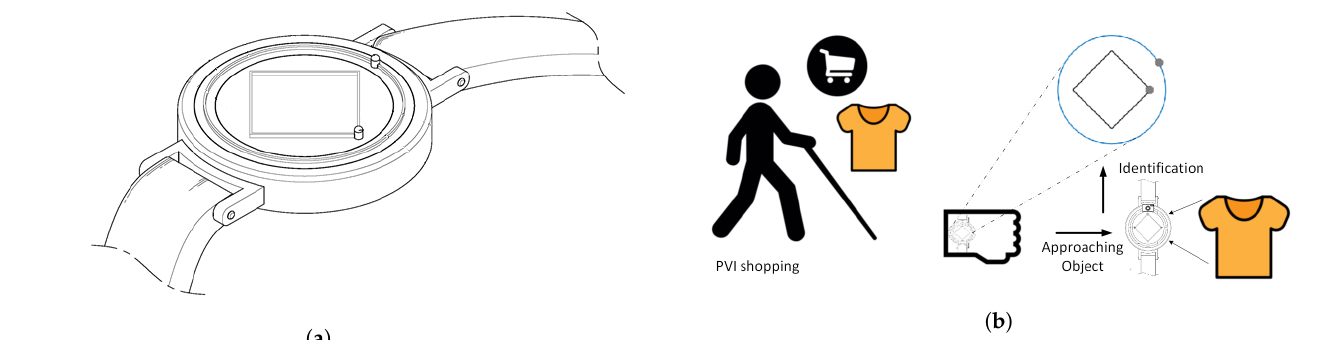
Figure 2. Perspective view of ColorWatch design concept; ( a ) PVI use scenario of ColorWatch during shopping ( b ).